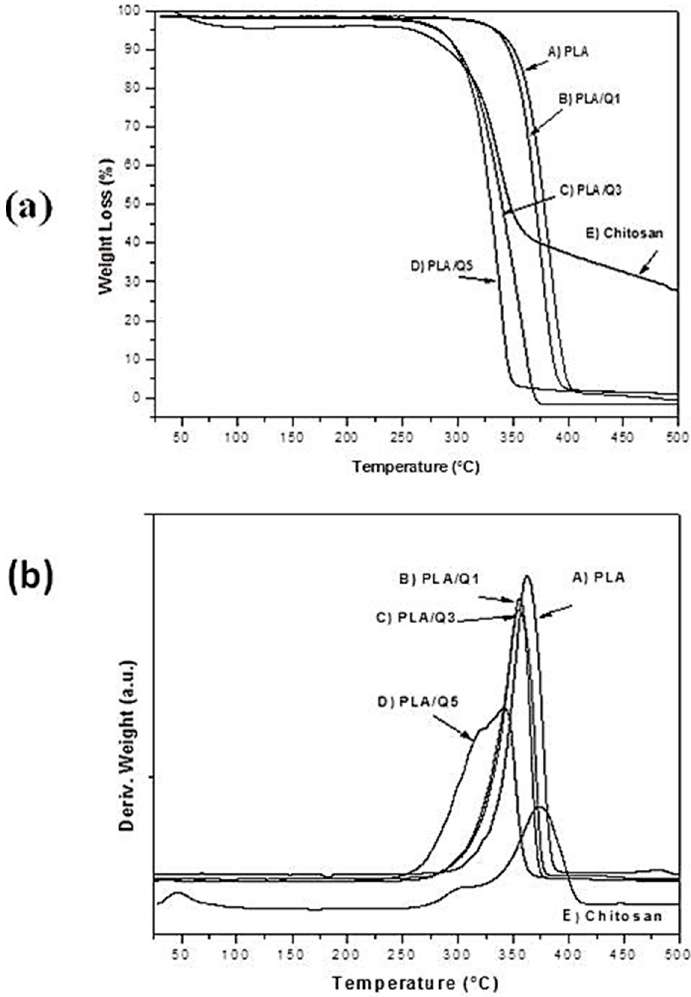
Figure 2. ( a ) Thermogravimetric (TG) and ( b ) TG derivative curves for PLA, chitosan and PLA/chitosan composites with 1 wt % (PLA/Q1), 3 wt % (PLA/Q3) and 5 wt % (PLA/Q5) chitosan.